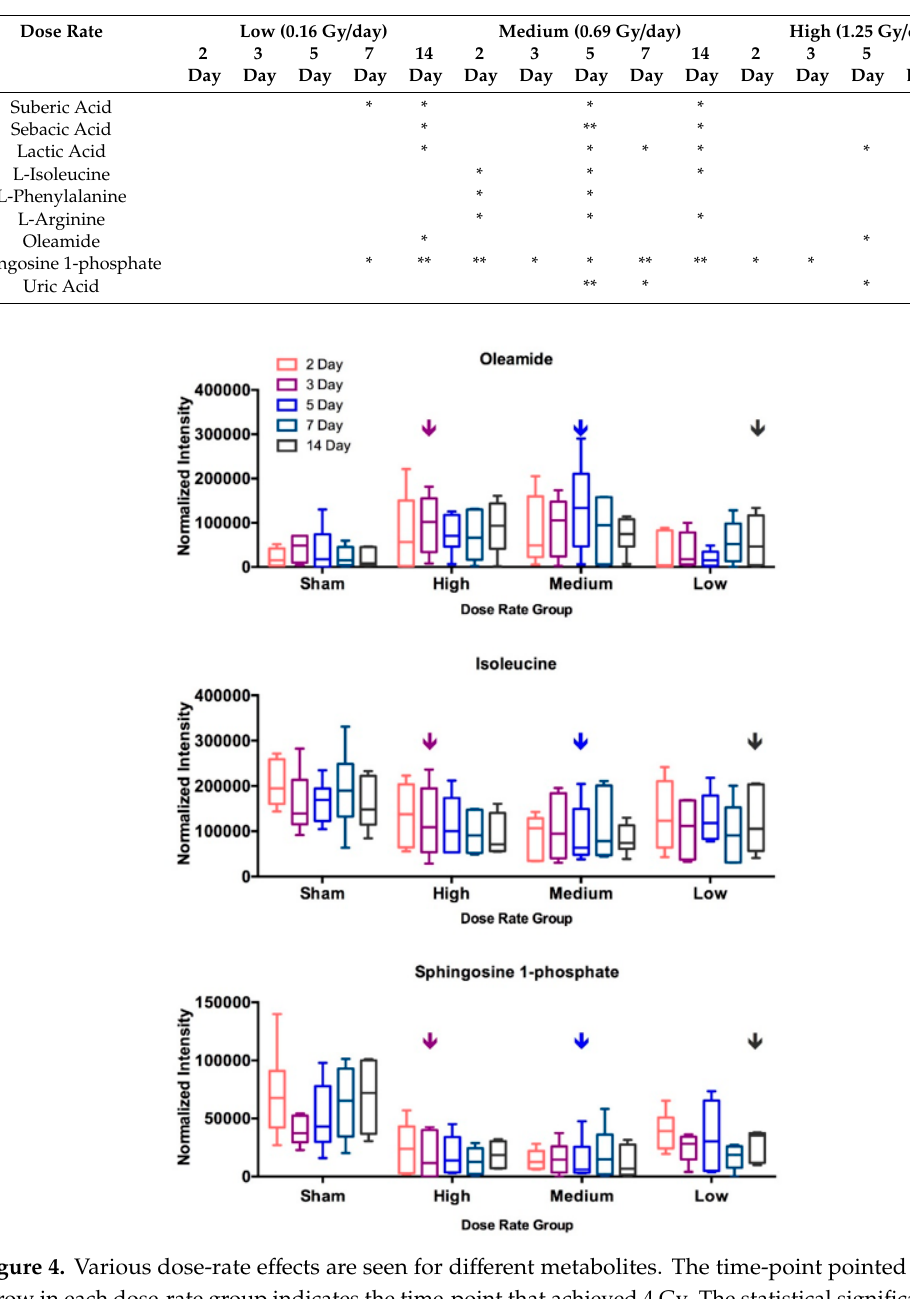
Table 2. Dose response in di ff erent dose-rate groups indicated by statistical di ff erence of these validated ions. *, p -value < 0.05; **, p -value < 0.01.